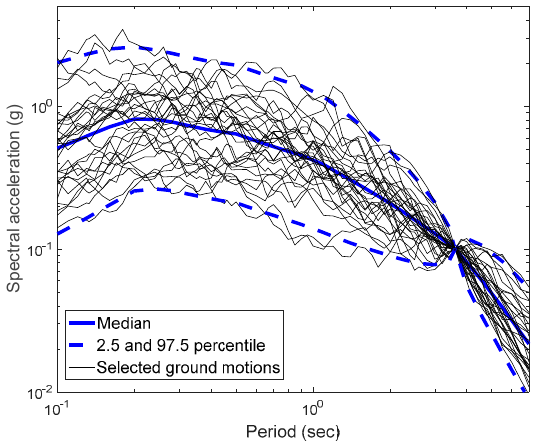
Figure 8. Target conditional spectrum and scaled GMRotD100 spectra for incremental dynamic analysis (Model B).